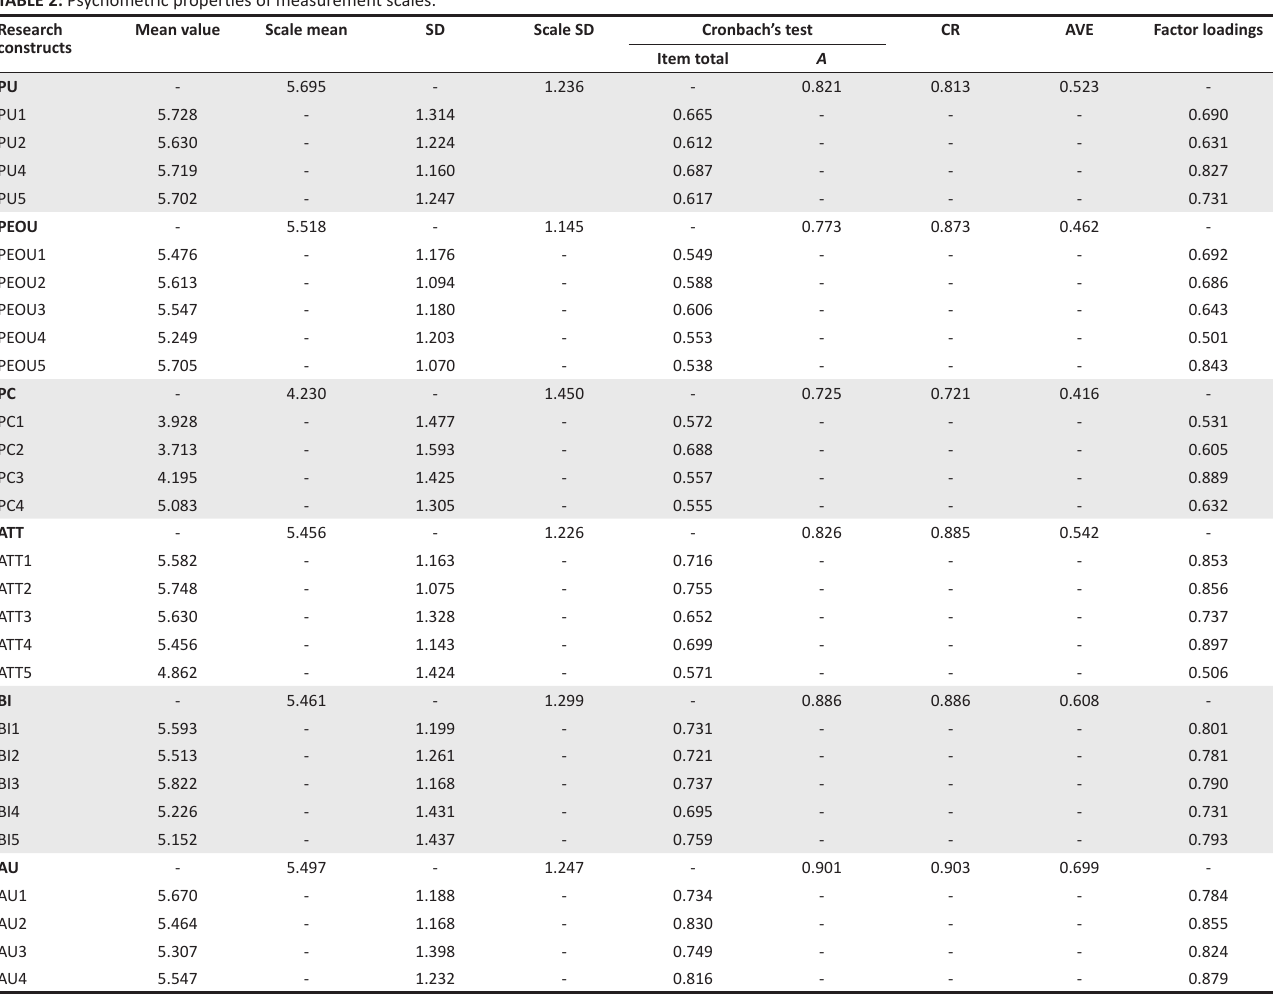
TABLE 2: Psychometric properties of measurement scales. Research constructs